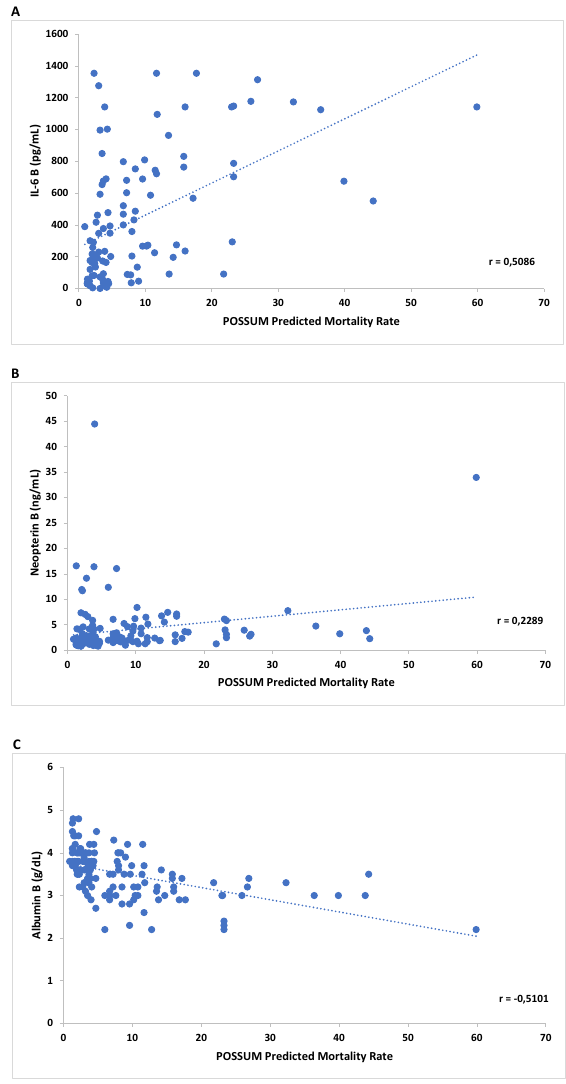
Figure 1: Global assessment of 132 patients displayed that calculated POSSUM predictive mortality rates (PPMR) significantly correlated with post-operative (A): IL-6, (B) neopterin and (C) albumin levels. Revised POSSUM predicted mortality rate was recalculated accordingly (Spearman’s rho correlation test: IL-6-PPMR: p=0.0000, neopterin-PPMR: p=0.0000 and albumin-PPMR: p=0.0000)